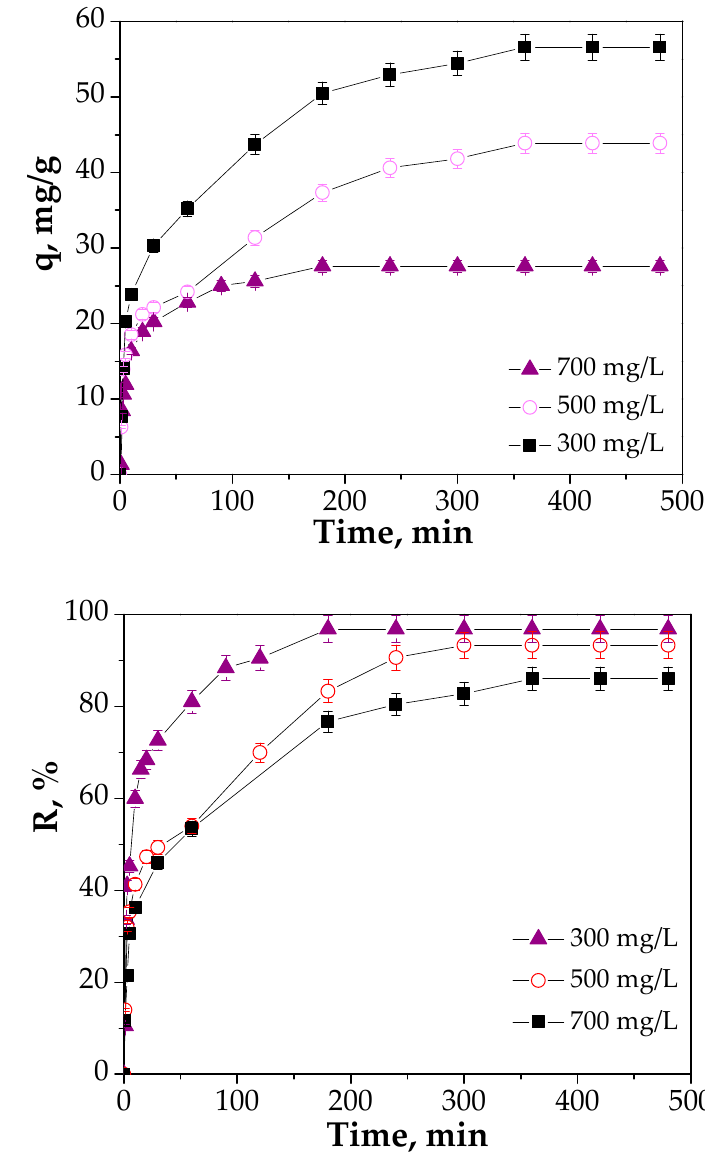
Figure 8. Effect of initial concentration and contact time.